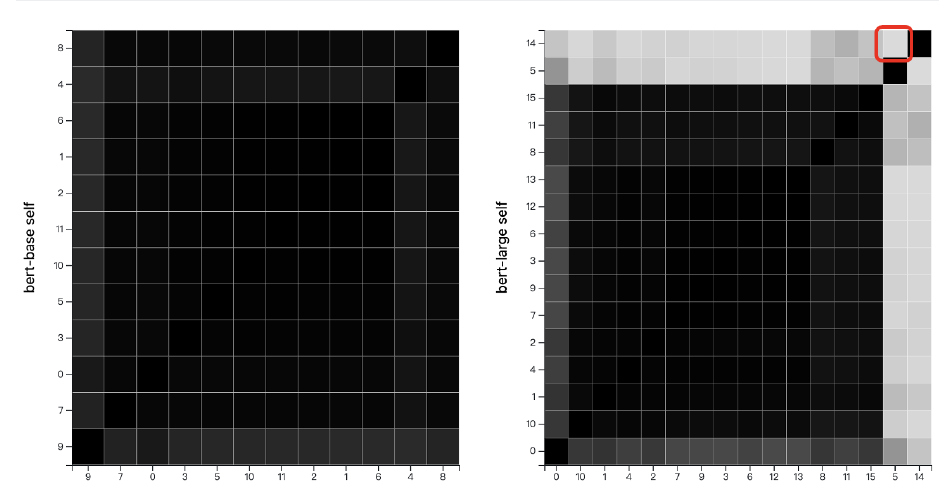
Figure 23. ( Left ) All heads in the bert-base are similar to each other. ( Right ) All heads in the bert-large are similar to each other except for the 14th and 5th heads (the red